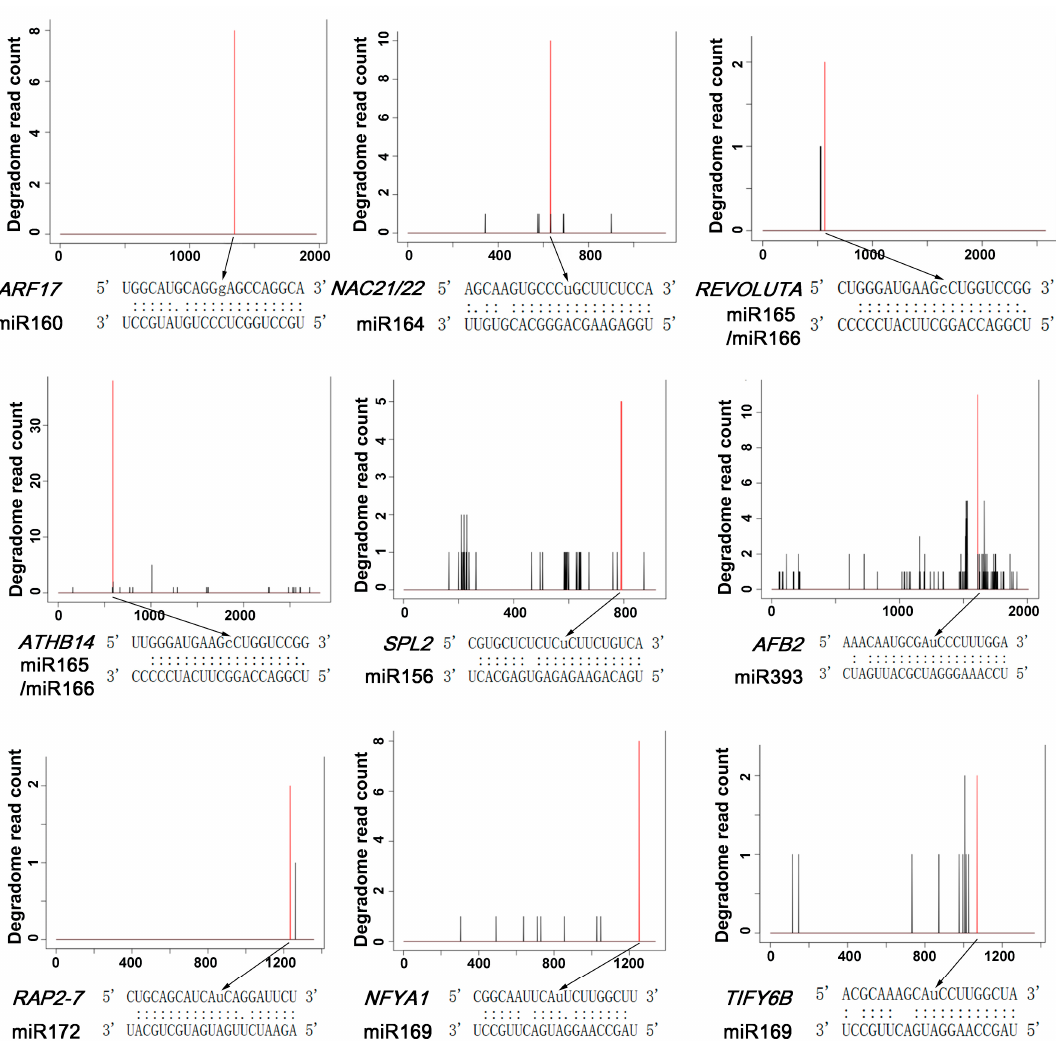
Figure 3. Identification of the cleavage sites of miRNAs by degradome sequencing in peaches. Cleavage sites of miRNAs on their targets were detected by degradome analysis. The X -axis indicates the mRNA position of miRNA targets from 5’ to 3’. The red bar shows the degradome read with the highest count on the mRNA. The miRNA duplex structures and their complementary regions on the targets are shown. Watson–Crick base pairs and G–U base pairs are indicated by “:” and “.”, respectively. Cleavage sites are indicated by black arrows and lower case